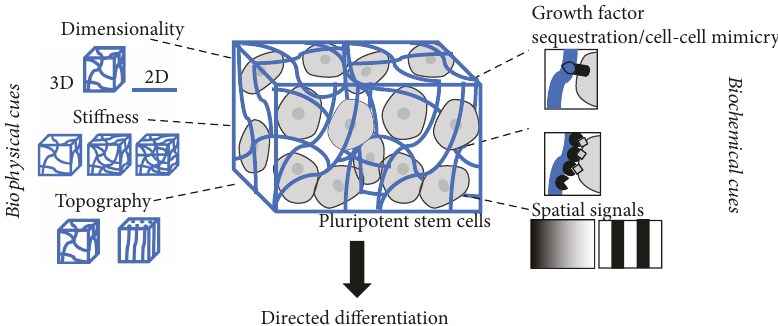
Figure 1: Biomaterial characteristics that are employed to in fl uence PSC fate and their potential therapeutic